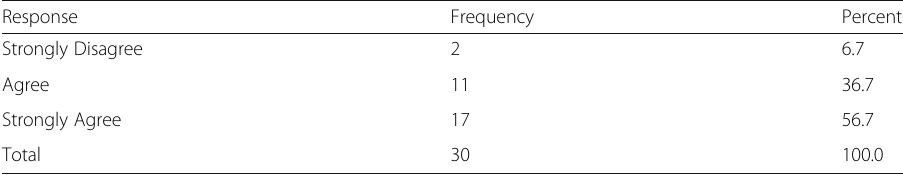
Table 5 Adaptation of new technologies in cargo handling process Response Frequency